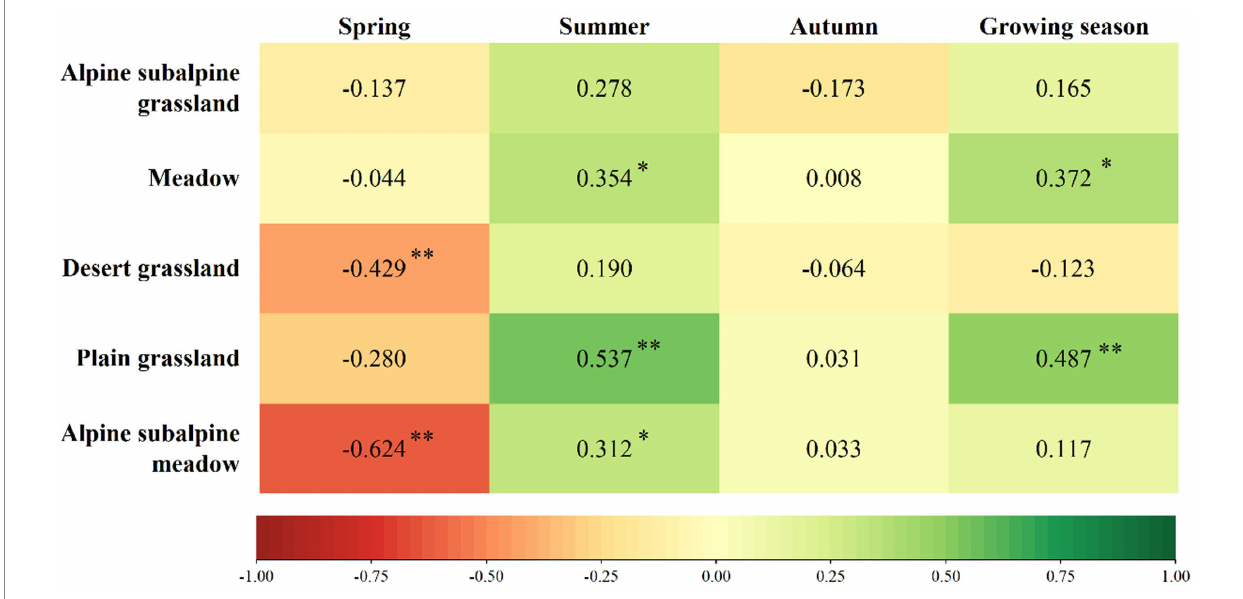
FIGURE 9 Correlation between SPEI and NPP for different grassland types in Xinjiang from 1982 to 2020. (* indicates a significance level of 0.05, whereas ** indicates a significance level of 0.01).